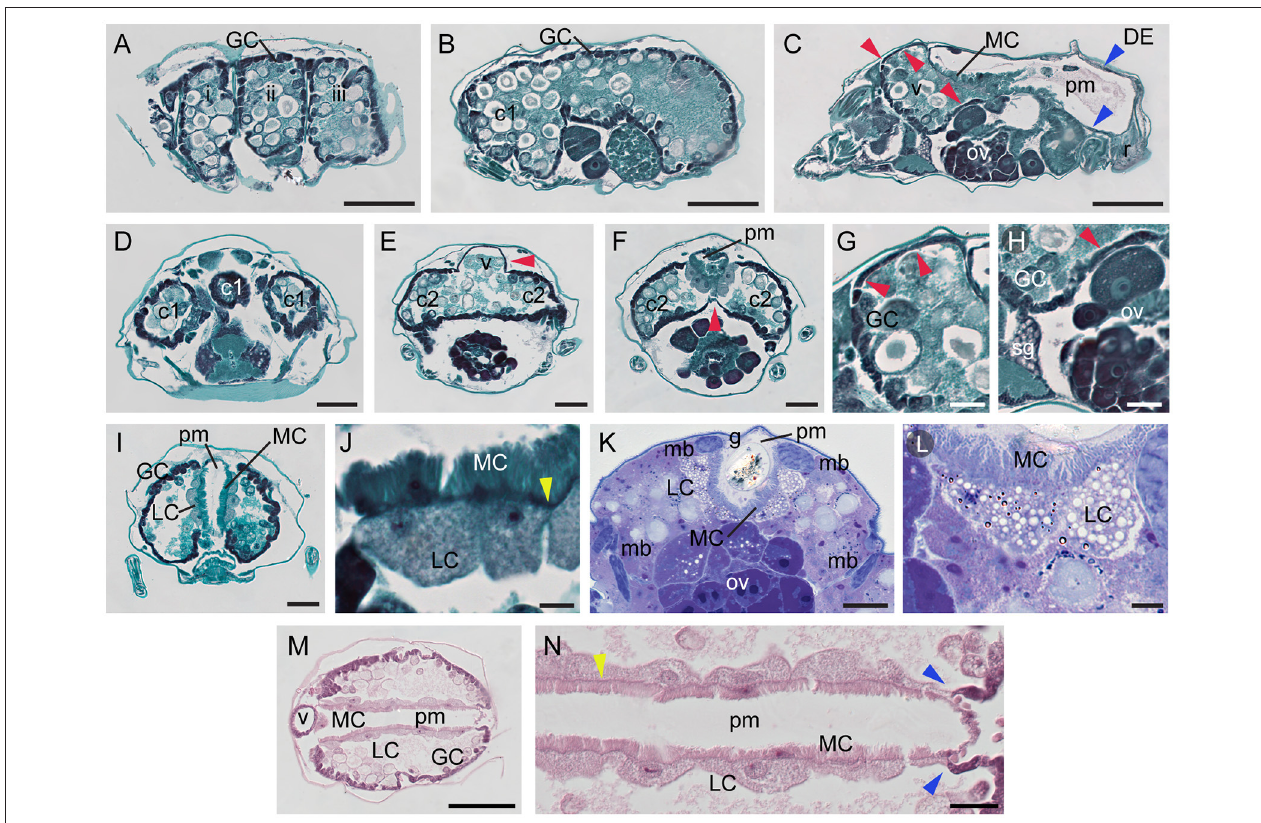
FIGURE 4 | Midgut of spider mite. (A–C) Serial sagittal sections of spider mite female progressing from outside part of the body (A) showing lateral caecal pouches (i–iii) to the middle (C) where posterior midgut (pm) becomes visible. Red arrowheads point to the ventricular epithelium at cranial caeca and ventriculus (v). Blue arrowheads point to the thin single-layered squamous cells that lack microvilli projections at the dorsal and posterior region of the posterior midgut, DE. r, rectum. (D–F) Transverse sections through region of cranial caeca (c1), ventriculus (v), and anterior portion of posterior midgut (pm). (G) Detail of thin dorsal ventricular epithelium (red arrowheads) which transitions to cuboid generative cell (GC) epithelium anteriorly. (H) Detail of thin ventral ventricular epithelium (red arrowhead) adjacent to silk gland (sg) and ovary (ov). (I) Representative transverse section of mite digestive system showing generative cells (GC) of midgut epithelium, large cells (LC) of midgut epithelium adjacent to posterior midgut (pm), and microvilli cells (MC) of posterior midgut. (J) Large cells (LC) of midgut epithelium opposite of microvilli cells (MC) of posterior midgut epithelium. Yellow arrowhead points to basement membrane. (K) Transverse section of LR White plastic embedded and Toluidine Blue stained spider mite. (L) Large cells (LC) of midgut epithelium opposite of microvilli cells (MC) of posterior midgut epithelium. (M) Longitudinal section through ventriculus (v), midgut and posterior midgut (pm) stained with hematoxylin and eosin. (N) Detail of the interface between LCs of midgut and MCs of posterior midgut. Basement membrane (yellow arrowhead) is very well defined in this preparation. Notice the immediate change of cell types in both midgut and posterior midgut epithelia as two become separated in the posterior region (blue arrowheads). Scale bars: (A–C) : 100 µ m; (D–F) : 50 µ m; (G,H) : 20 µ m; (I) : 50 µ m; (J) : 10 µ m; (K) : 30 µ m; (L) : 10 µ m; (M) : 100 µ m; (N) : 20 µ